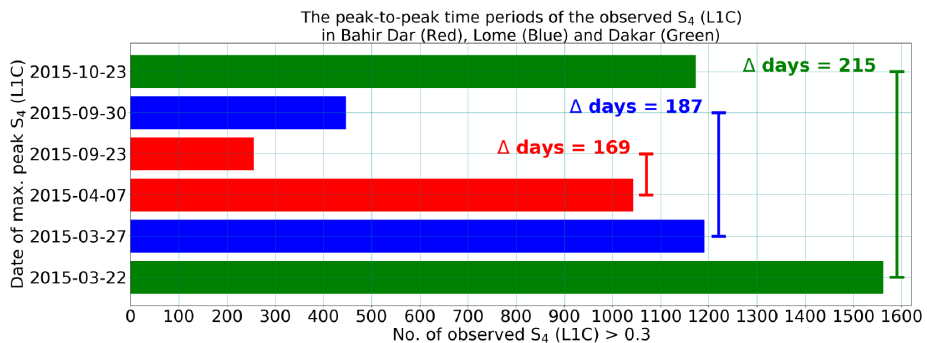
Figure 8. Peak-to-peak time periods of S 4 scintillation occurrences at GNSS stations Bahir Dar (red), Lomé (blue) and Dakar